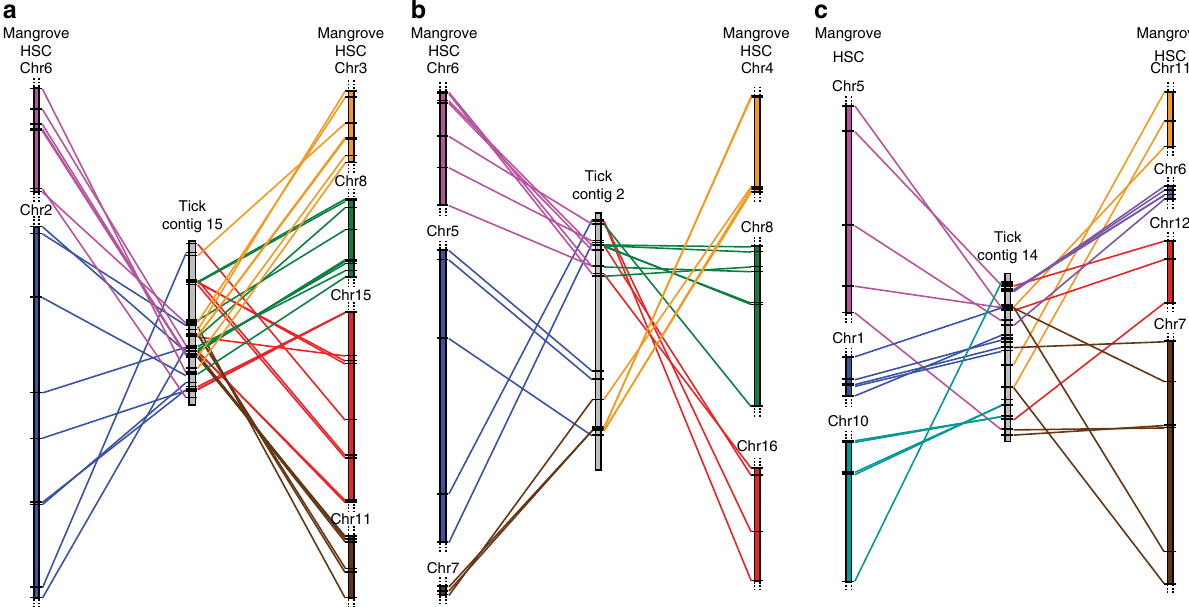
Fig. 6 Syntenic relationship between tick contigs and mangrove HSC chromosomes. Relative positions of orthologues between tick contig 15 ( a ; 5.5 Mb), contig 2 ( b ; 12.4 Mb) and contig 14 ( c ; 5.5 Mb), and mangrove HSC chromosomes are shown. Colored vertical bars represent contigs (tick) or chromosomes (mangrove HSC) whereas the horizontal black lines represent orthologous genes. Dotted lines indicate that the chromosomal region extends beyond what is